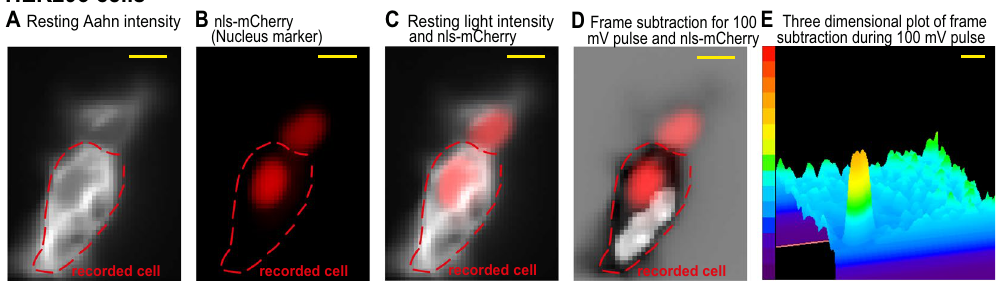
Figure 2. The overlap between nucleus marker and the internal signal area in an HEK293 cell. The region of the internal signal and the nuclear marker do not overlap. HEK 293 cells expressing Aahn and nls-mCherry were voltage-clamped. ( A ) The resting light fluorescence image of Aahn expression. ( B ) A red florescent protein (nls-mCherry) was used as a marker for nuclei. ( C ) The merge of resting light image of the HEK293 cells expressing Aahn (white) and nls-mCherry (red). ( D ) Merge of frame subtraction and nls-mCherry (red) (from the same HEK 293 cell as shown in Fig. 1). ( E ) The 3 dimensional plot of the frame subtraction during the 100 mV depolarization pulse filtered using two iterations of a low-pass spatial filter (3 × 3 Mean). The color scale indicates the light intensity with the red and purple indicating the brightest and the darkest pixels. The size bars represent 10 μ